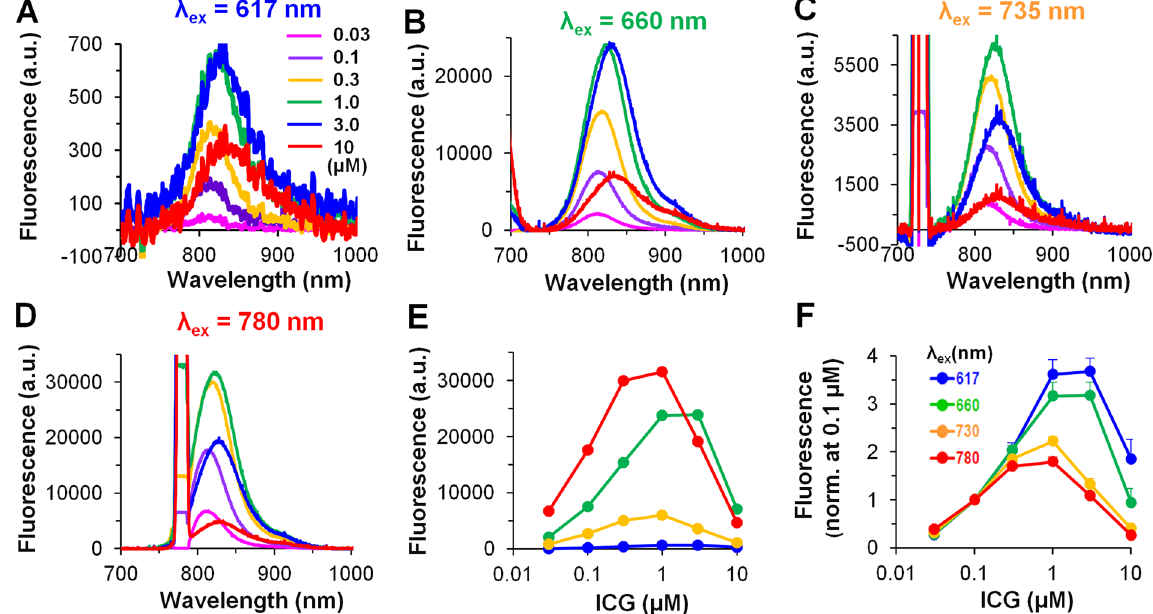
Figure 1. Fluorescence spectra of the ICG OSs as a function of dye concentration in the heart. ( A – D ) Mean values (n = 3–7) of ICG fluorescence at λ ex of 617 nm, 660 nm, 735 nm, and 780 nm, respectively. ( A ) Insert - ICG dye concentrations as indicated in µ M; ( B – D ) same labels as in ( A ). ( C,D ) on the left side of the spectra, the LEDs excitation light is seen. ( E,F ) Emission peaks at increased concentrations of the ICG dye: fluorescence intensity in arbitrary units (a.u.), and after fluorescence normalization (at 0.1 µ M of the ICG), respectively; same fluorescence data as in ( A–D ). ( F ) Insert - λ ex = 617 nm ( blue ), λ ex = 660 nm ( green ), λ ex = 735 nm ( yellow ), and λ ex = 780 nm ( red ); ( E ) same labels as in ( F ). Note the difference in the fluorescence intensity when ICG concentrations > 0.3 µ M were used. Error bars indicate